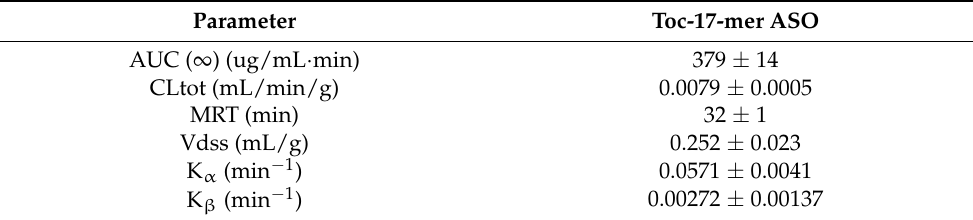
Table 6. Pharmacokinetic parameter of Toc-17-mer ASO.